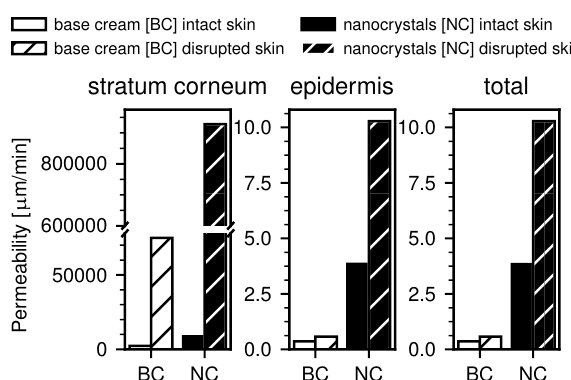
Figure 6. Computed permeability coe ffi cients from the numerical data. The permeability in the SC is the highest, due to the free energy minimum here and the smaller length scale. All obtained permeabilities are higher for the case of the nanocrystal formulation compared to the base cream. Also, barrier-disrupted skin shows higher permeability compared to intact